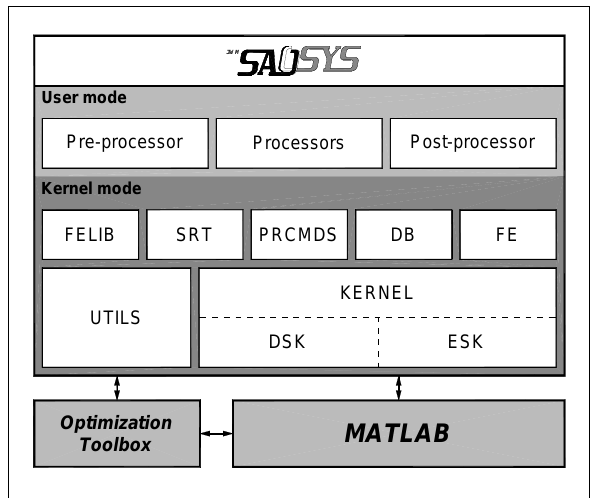
Fig. 13. The architecture of JWM SAOSYS Toolbox v0.42